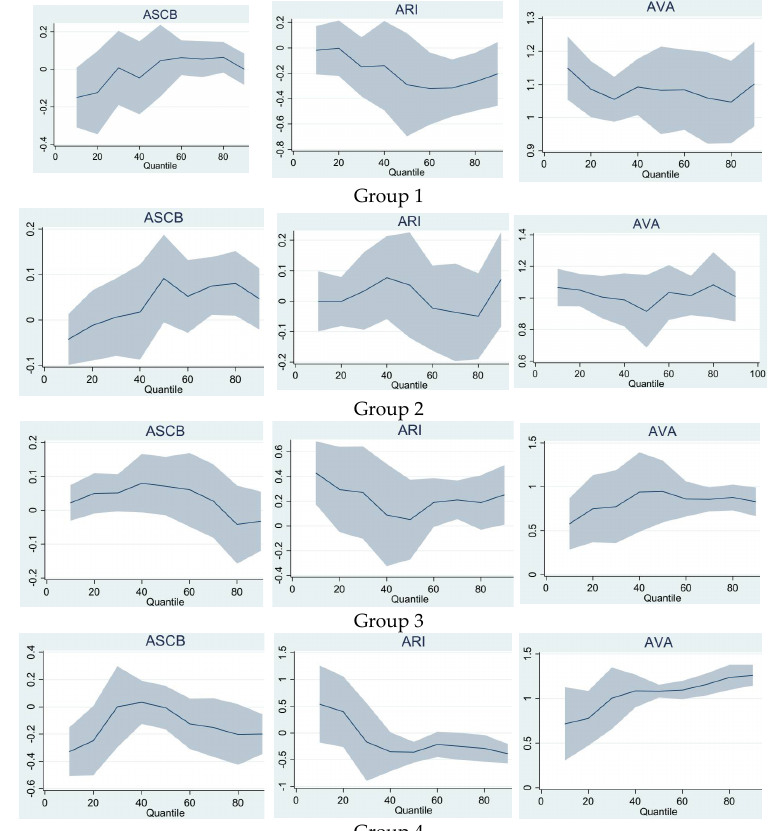
Figure 2 depict the changes in parameter estimates for main variables of financial health and economics, ranging from 0.01 to 0.99 quantiles of the distribution with 95% confidence intervals in the shaded area, and the trended lines represent quantile regression coefficients.